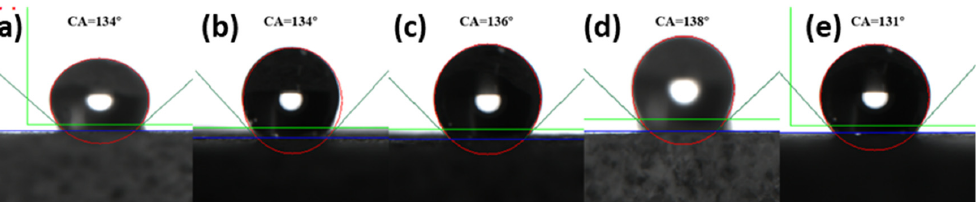
Figure 8. The contact angle of the treated core sheet after ultrasonic cleaning. ( a – e ) the contact angles on the treated core sheet after being cleaned with pure water for 5 min, 10 min, 20 min, 30 min, and 45